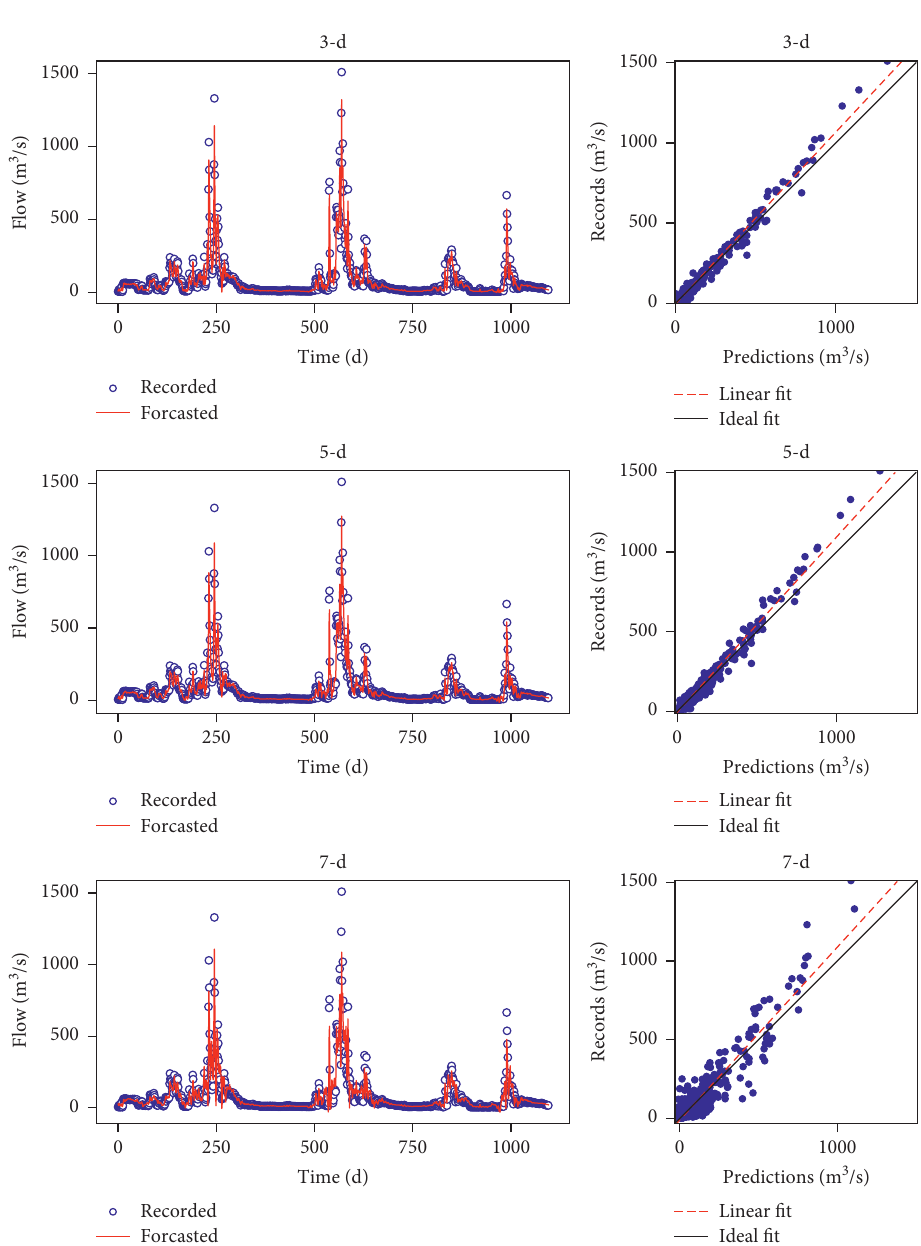
Figure 11: Final predicted results and the scatters of the VMD-BPNN for the 3-d, 5-d, and 7-d ahead forecasts at the Weijiabao